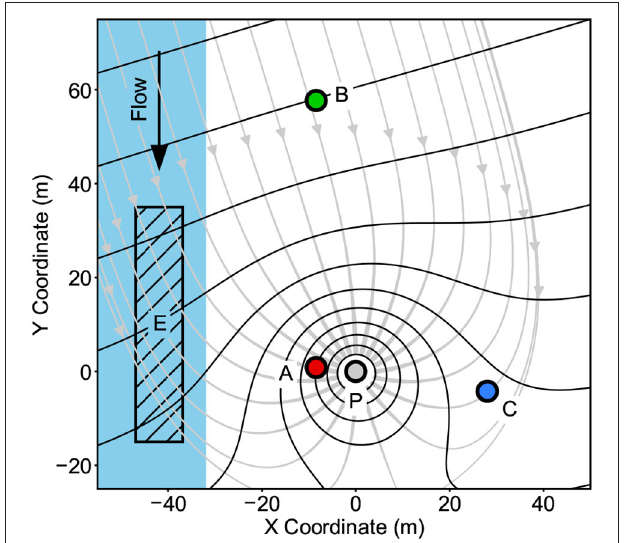
FIGURE 1 | Schematic map of the test site showing the locations of the piezometers used for tracer injection (A, B, C), the pumping well (P), a qualitative illustration of the assumed hydraulic head (black contour lines) and groundwater flow (gray lines with arrows) before riverbed excavation, the river (blue), and the approximate area of the riverbed excavation (E).